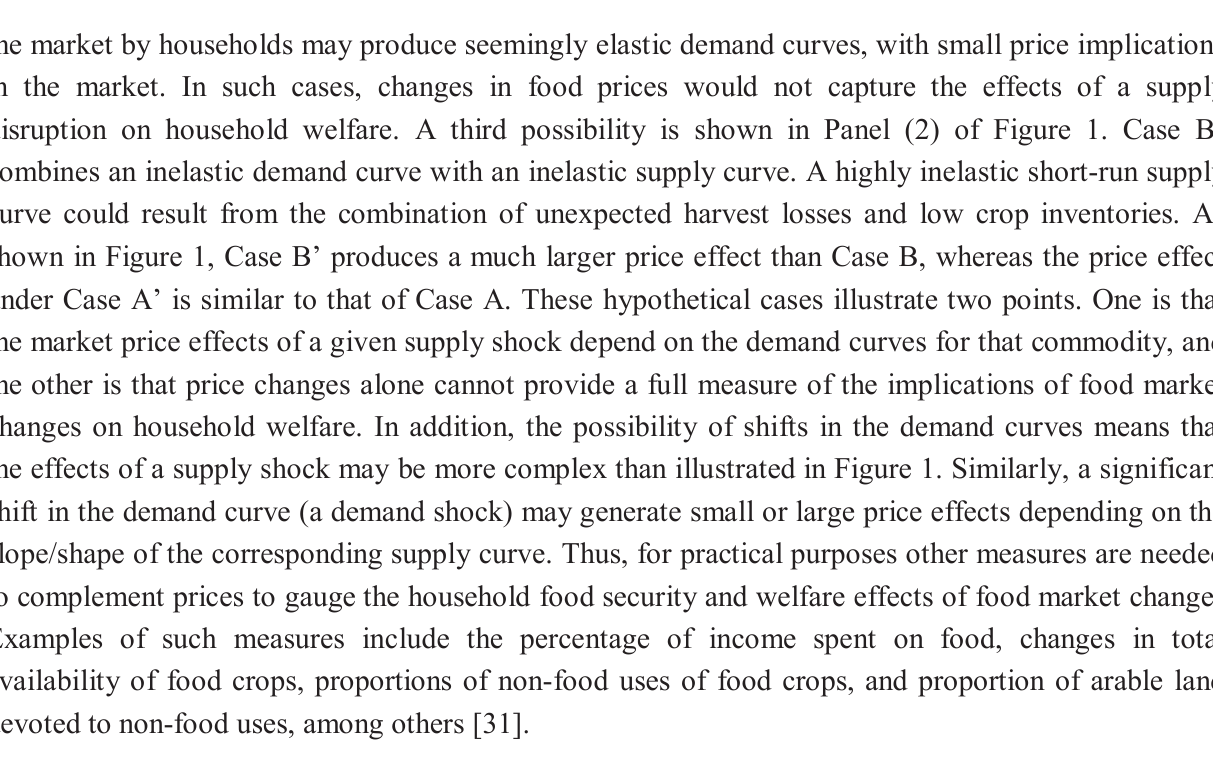
Figure 1. Illustration of potential price changes in the food market under a supply